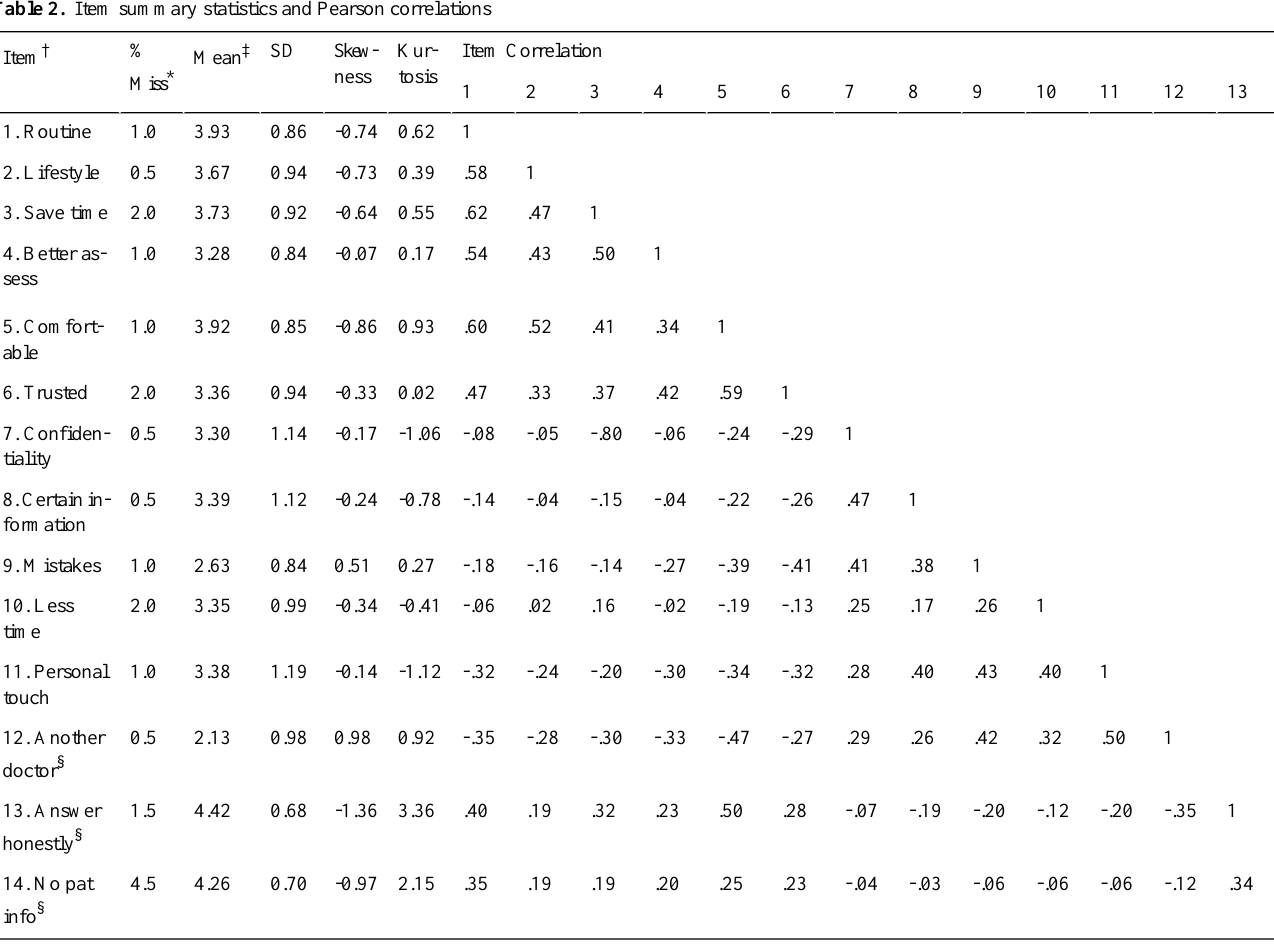
Table 2. Item summary statistics and Pearson correlations